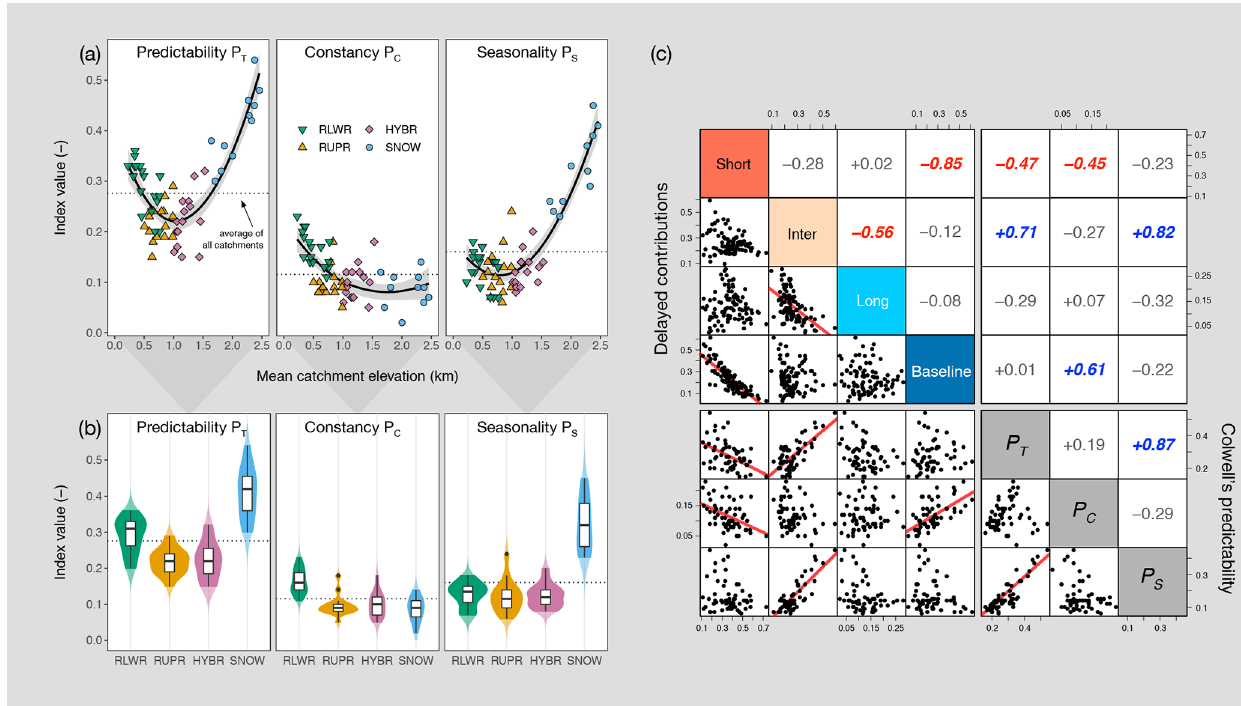
Figure 8. Overview of Colwell’s predictability ( P T ), which is equal to constancy ( P C ) plus seasonality ( P S ), for (a) all catchments and (b) the four catchment groups (higher saturation of violin plots delimits the data range). (c) Relationship (i.e. Pearson’s correlation coefficient) between relative streamflow contributions in the four delay classes and the components of Colwell’s predictability ( P T = P C + P S ). Coloured coefficients are statistically significant ( p value of <